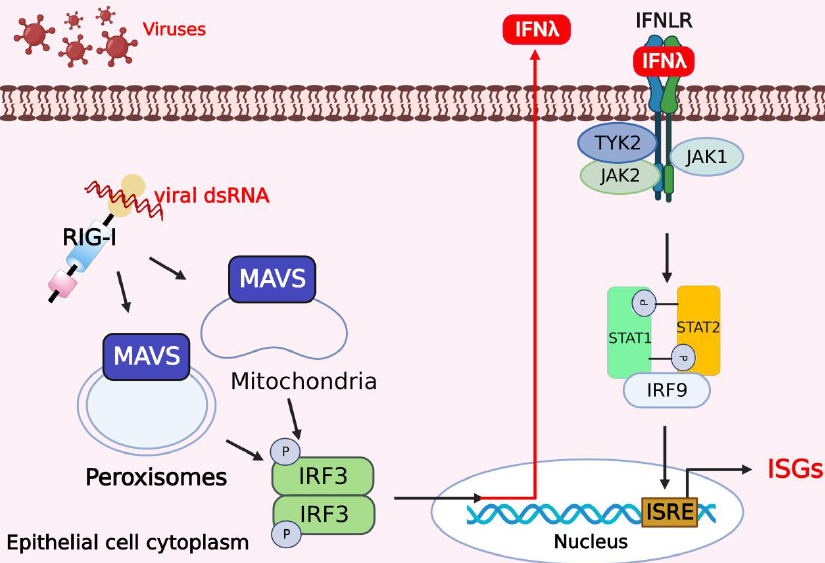
Figure 2. Activation of type III IFNs and downstream signaling pathways in response to viral infections. In human cells, especially in epithelial cells, mitochondrial antiviral signaling protein (MAVS) on peroxisomes and mitochondria promotes the expression of IFN- λ to activate the JAK/STAT pathway regulated by JAK2 and induces selective expression of IFN- λ . The figure was created using the online software “Biorender” (https://app.biorender.com/ The updated figure was created on 7 December